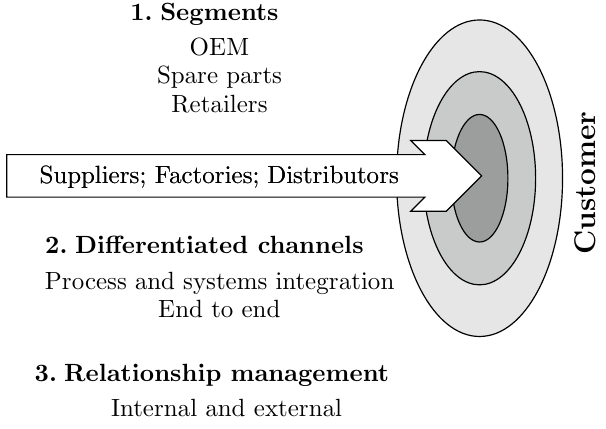
Figure 9: The SKF channel concept (Ericsson